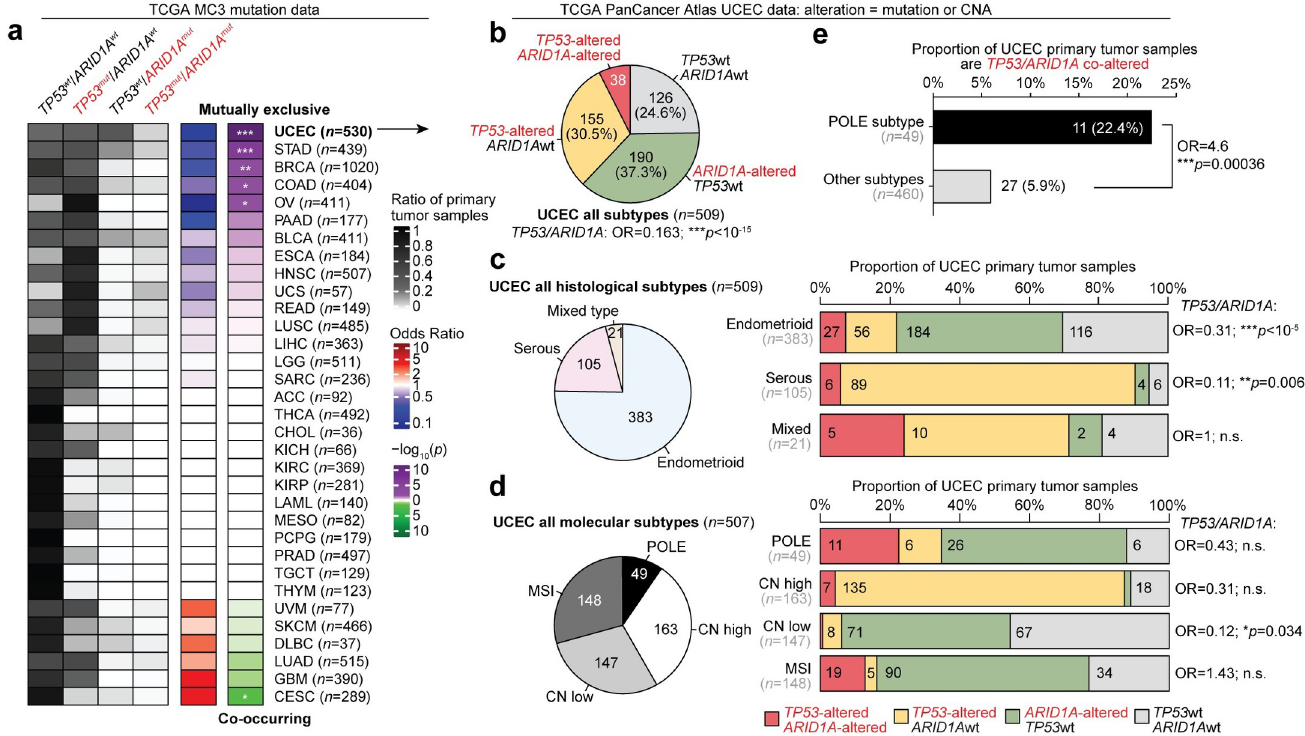
Fig 1. TP53 and ARID1A mutations rarely co-occur in endometrial cancer. a , Pan-cancer analysis of TP53 and ARID1A mutation rates across 33 TCGA tumor types, only considerate of somatic single nucleotide variants. For heatmap, darker color indicates a greater proportion of sequenced tumor samples. Odds ratio (OR) and statistics for each tumor type accompany two-tailed Fisher’s exact tests performed on TP53 and ARID1A mutation contingency tables. Asterisks indicate significant associations between TP53 and ARID1A mutations, either co-occurring or mutually exclusive: � p < 0.05; �� p < 0.01; ��� p < 0.001. b , Details within the Uterine Corpus Endometrial Carcinoma (UCEC) cohort ( n = 509), further inclusive of copy number alteration (CNA) events. TP53 and ARID1A mutation classes (left) and distribution of histological subtypes (right) across the UCEC cohort. c , Left, distribution of UCEC histological subtypes: endometrioid, serous, and mixed. Right, TP53 and ARID1A alteration rates and association of co-occurrence for primary tumors within each histological subtype. d , As in c but for UCEC molecular subtypes: POLE mutant, copy-number alteration high (CN high), CN low, and microsatellite instable (MSI). e , Association between POLE mutant molecular subtype tumors and TP53/ARID1A co-alterations. Statistic is two-tailed Fisher’s exact test.